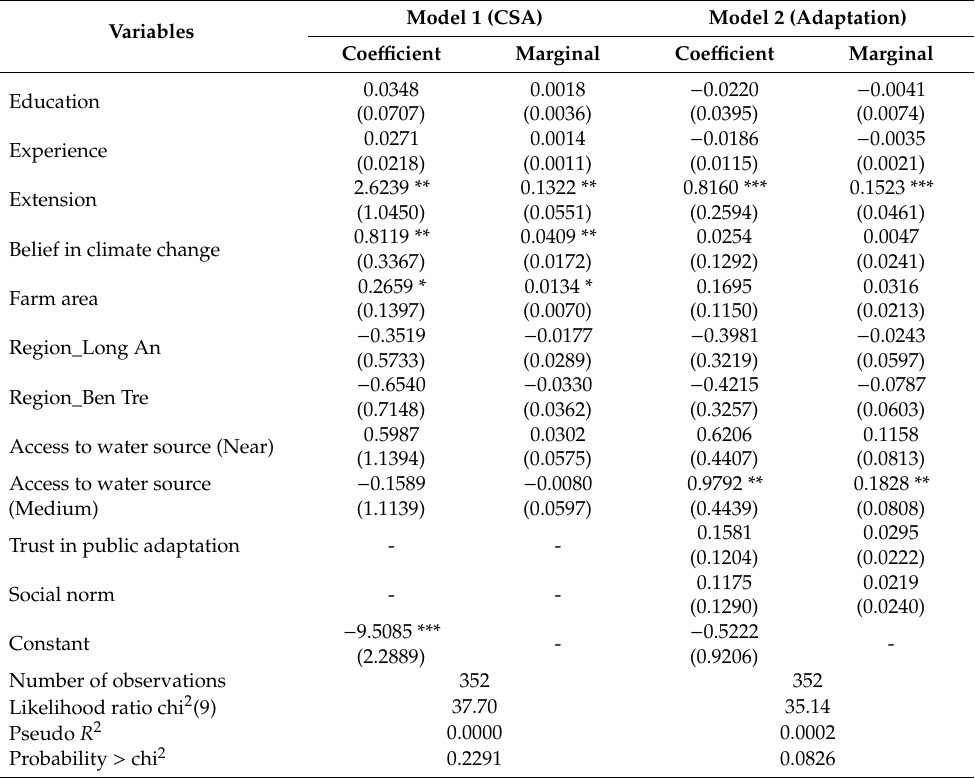
Table 7. The propensity score